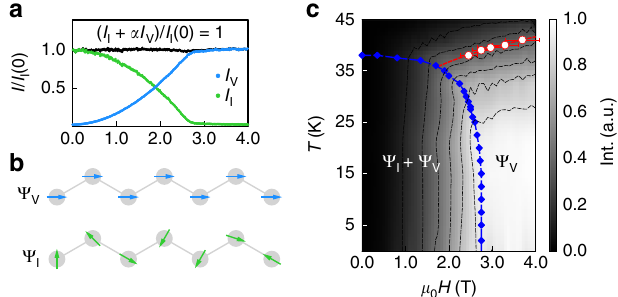
Fig. 4 T – H phase diagram of β -Li 2 IrO 3 with fi eld along b -axis. a Ψ I and Ψ V obey a simple sum rule which suggests that spectral weight is exchanged between these parameters as a function of fi eld. b Schematic representation of the moment direction in the zero fi eld incommensurate (lower, green arrows) and the fi eld induced zig-zag (upper, blue arrows) order projected on the Ir chains (gray) which propagate in the crystallographic a ± b directions (see also Fig. 1a). Note the propagation vector of the incommensurate order is not along the chain, but along the a -axis. c T − H phase diagram constructed by combining the normalized scattering intensity of a commensurate peak (gray scale contours), with the H * and T I extracted from magnetization and heat capacity measurements in Fig. 1 (blue diamonds), and a cusp observed in the fi eld dependence of C p (red dots) (determination of the error bars is described in the caption of Supplementary Fig. 3). Note the parameter Ψ V in principle grows as the ffiffiffiffiffi structure factor and so Ψ V ∝ I V